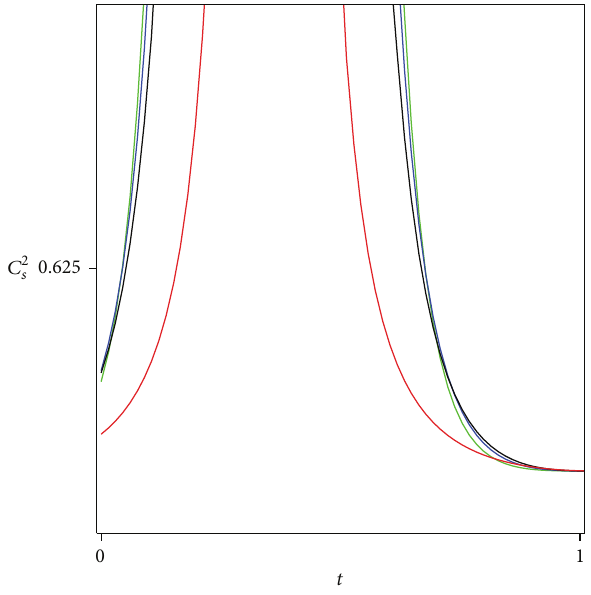
Figure 16: Time evolution of 𝛿 for 𝐵 = 3 , 𝐶 3 = 1 , 𝛼 = 0.5 , 𝑘 = 0 , 𝑛 = 3 , and 𝐴 = 1/3 .